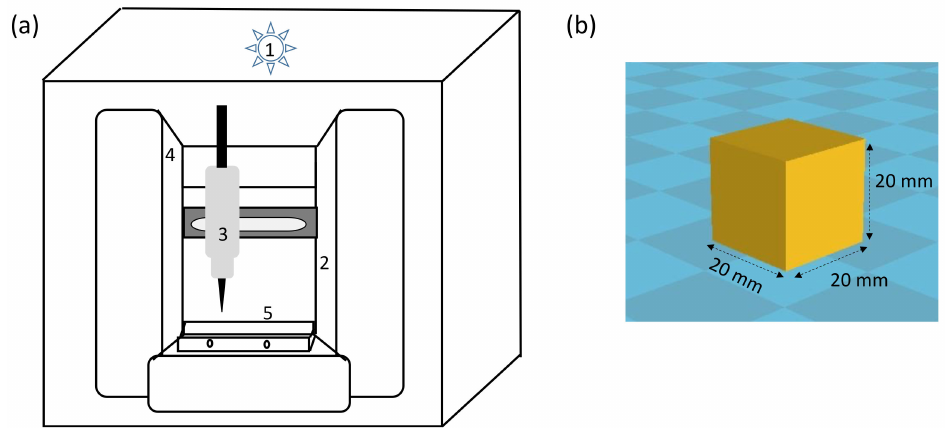
Figure 1. Schematic of the AM system, showing ( a ) heater position (1) and sensor position (2–5), and ( b ) the geometry of the printed product.